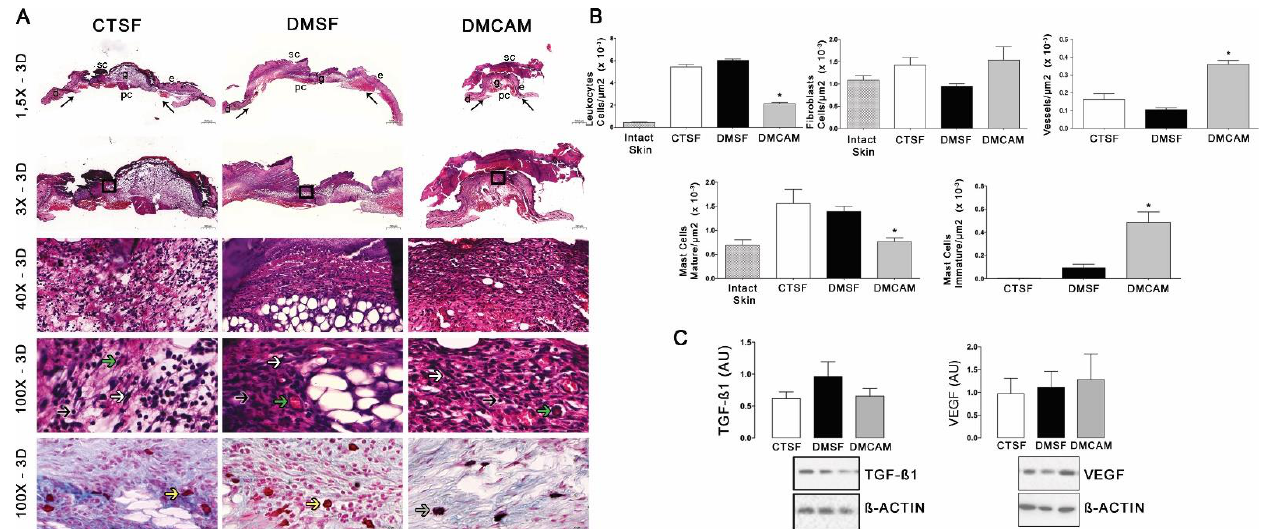
Figure 3. Topical treatment with plasticized chitosan-alginate membranes in hyperglycemic mice reduced the number of inflammatory cells and fibroblasts and increased the density of new vessels in the wound bed. ( A ) photos representing skin stained with H&E, post-wound day 3; less enhanced black arrows indicate the location where the excisional wound was performed. Small letters represent: sc, scab; e, epidermis; g, granulation tissue; d, dermis; pc, panniculus carnosus. Boxes in the upper panels indicate areas where regions that were amplified are shown to illustrate leukocytes (black arrows), fibroblasts (white arrows), and new vessels (green arrows). ( B ) number of leukocytes, fibroblasts, vessels, and blood capillaries by µ m 2 × 10 − 3 ; at day 3, the DMCAM group showed significantly smaller number of leukocytes and mature mastocytes than CTSF and DMSF groups. Safranin on skin fragments on day 3 after creating the wound on the backs of mice for analysis of mature mastocytes (yellow arrows) and immature mastocytes (grey arrows). ( C ) Analysis of the skin fragment (wound) with Western Blotting, with VEGF and TGF − β 1 and Beta Actin (Control), of animal groups CTSF, DMSF and DMCAM, on post-wound day 3. * Groups statistically different ( p < 0.05), compared by One-way ANOVA, followed by a Tukey multiple comparison test. Enlargements